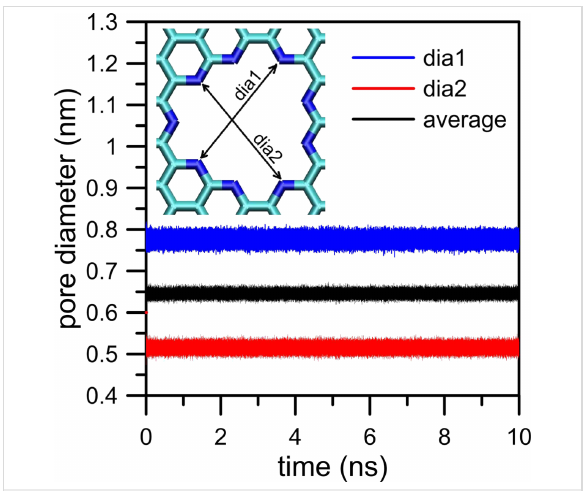
Figure 18: Time evolution of the second kind of deviation. Data were determined from the simulation trajectory of CH 4 + N 2 + 200 H 2 O at 300